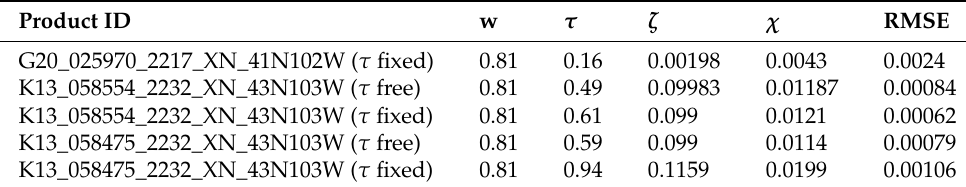
Table 4. Parameters obtained by Bayesian optimization in MATLAB ® based on sample profiles in the three images with free and fixed values of τ . The fixed values are taken from Montabone et al. [33] and Montabone et al. [34]. For G20_025970_2217_XN_41N102W, τ is fixed and all other parameters are free. The resulting mean albedo w 0 from that image is 0.81, and is consequently used as a fixed mean albedo for the other